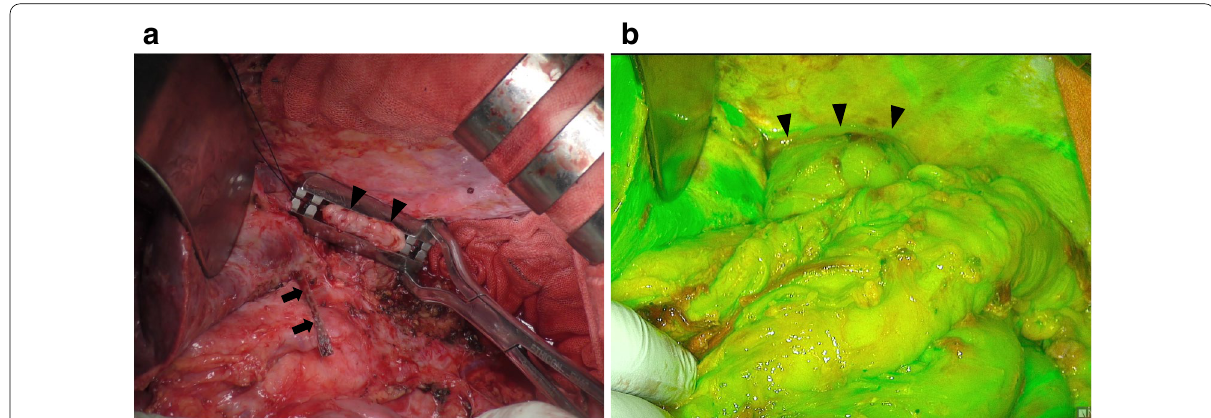
Fig. 3 Intraoperative findings after resection and reconstruction. a After partial resection of the jejunal limb together with a distal pancreatectomy. The esophagus (arrowhead) was resected at the side proximal to the esophagojejuno-anastomosis. The pancreas was divided at the site